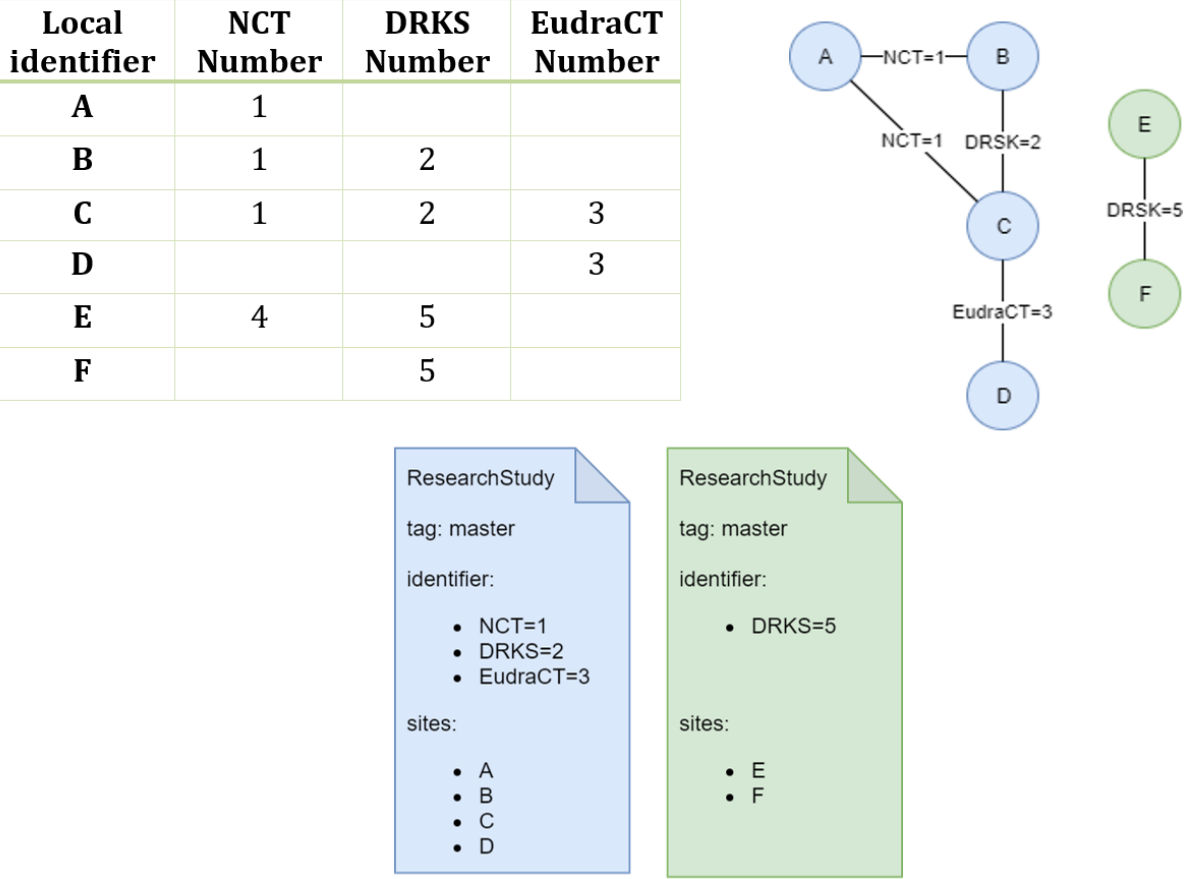
Figure 4. Example of 6 exported records, 4 of which (A-D) refer to one multicentric study (NCT=1, DRKS=2, EudraCT=3), and 2 of which (E and F) refer to a different multicentric study (NCT=4, DRKS=5), represented as a table (left) and an undirected graph (right). These studies are merged into 2 master ResearchStudy resources, each with a distinct set of identifiers and participating sites